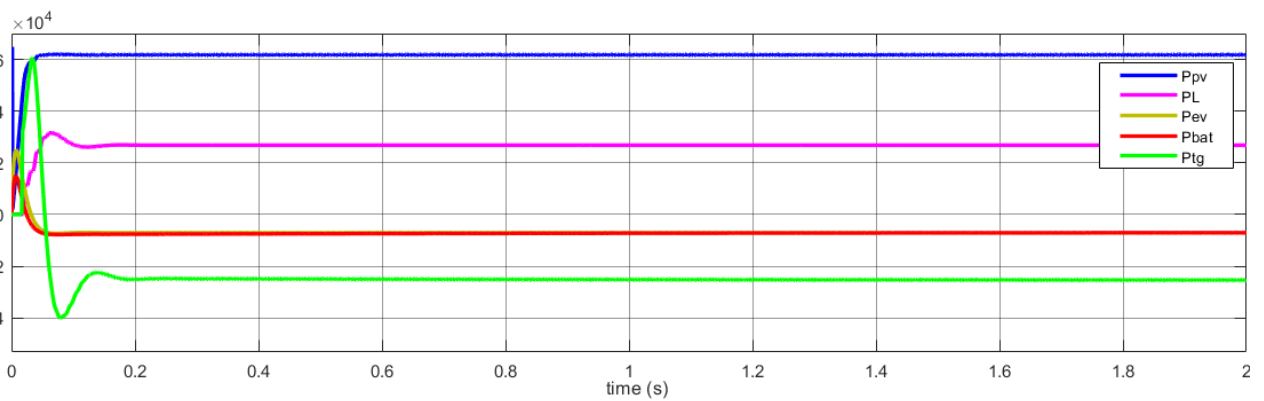
Figure 7. Residential system power fl ow with V2H.